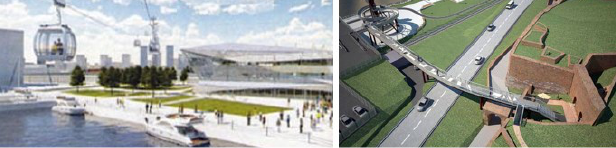
Figure 11. Cable car Project and pedestrian bridge for connecting Belgrade with the rivers